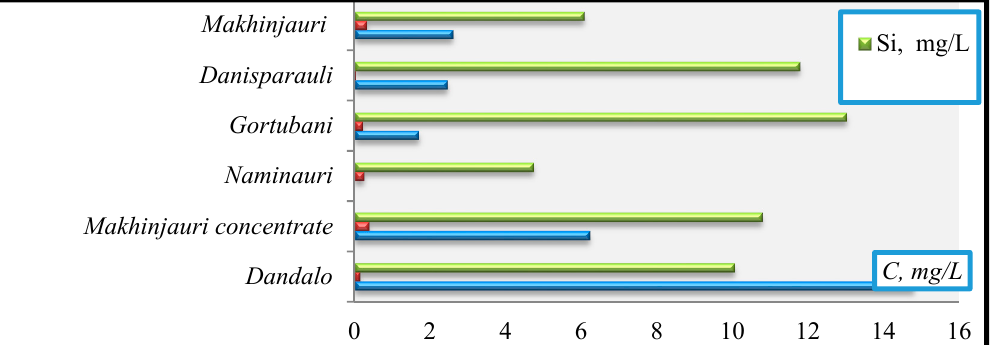
Figure 14. The content of Sb and Pb in the mineral waters.